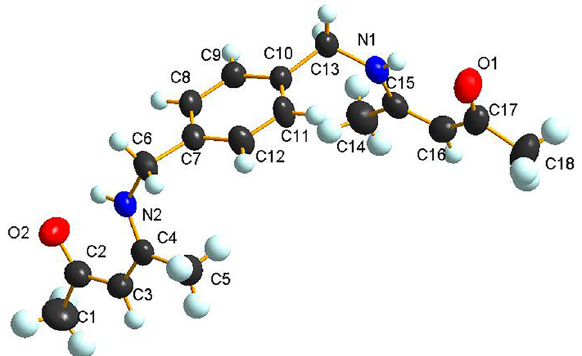
Table  : Data collection and